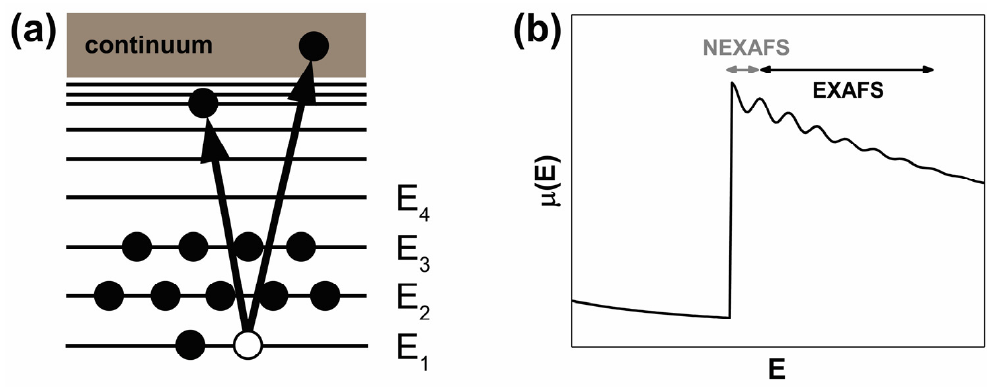
Figure 8. ( a ) Schematic of the transition of core electrons into an unoccupied bound state or continuum state, and ( b ) absorption coefficient µ ( E ) versus photon energy E . The spectral ranges of NEXAFS and EXAFS are labeled.